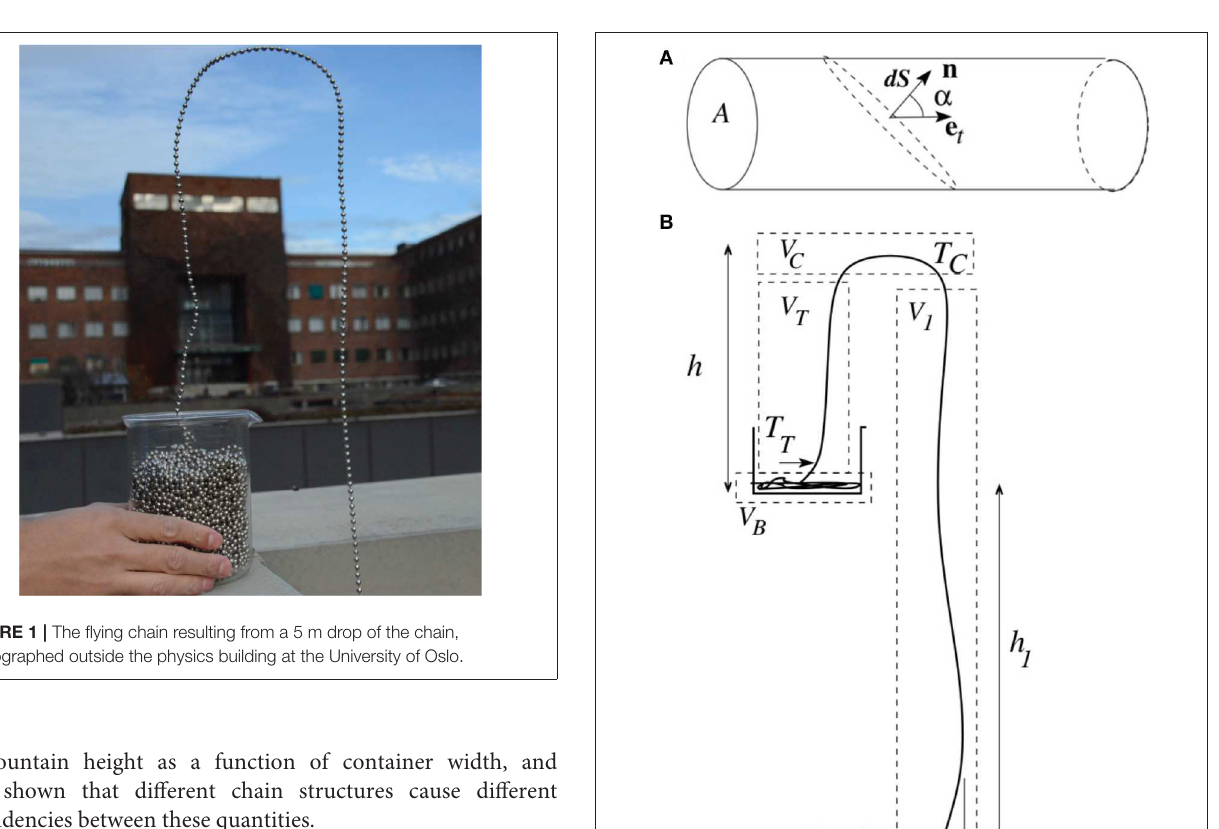
the fountain height as a function of container width, and it is shown that different chain structures cause different dependencies between these quantities.